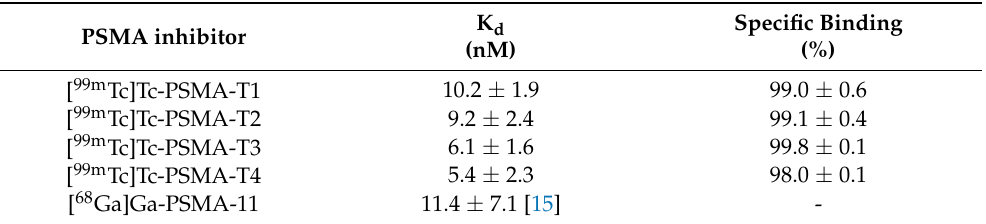
Table 4. The K d values and specific binding of the PSMA inhibitors were determined in the satura- tion binding assay.